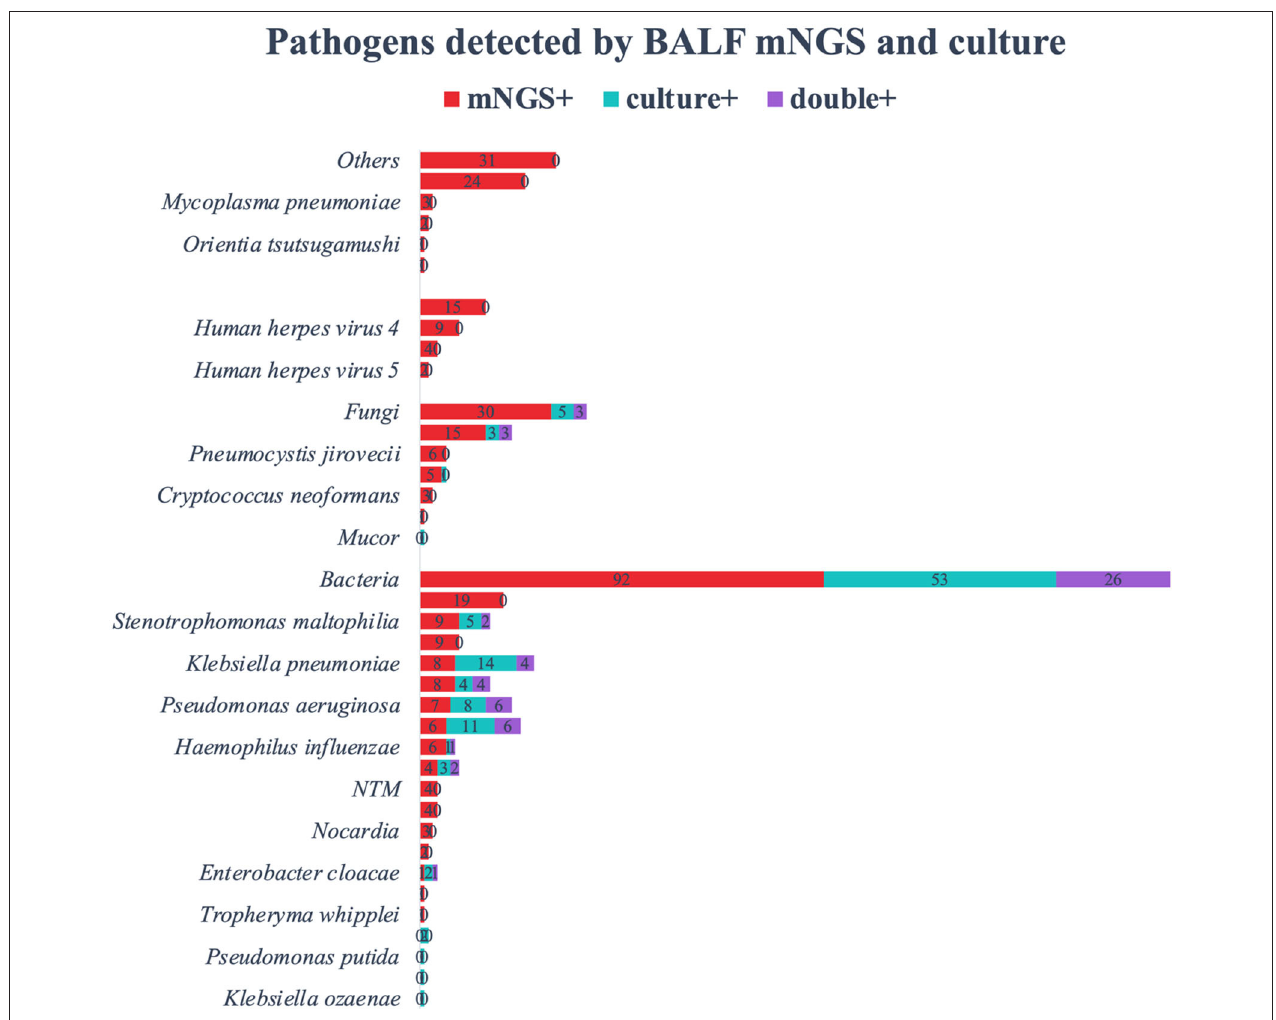
FIGURE 4 | The overlap of positivity between BALF mNGS and BALF culture. Bacteria were the most detected, followed by fungi, special pathogens, and viruses. The positive rate of BALF culture in detecting Klebsiella pneumoniae and Acinetobacter baumannii was higher than that of mNGS. Chlamydia psittaci was the most detected by mNGS, followed by Haemophilus parainfluenzae and Candida albicans. All viruses, special pathogens, MTB and NTM were only detected by mNGS, and the BALF culture of these pathogens were negative. BALF, bronchoalveolar lavage fluid; mNGS, metagenomic next generation sequencing; MTB, Mycobacterium tuberculosis ; NTM, nontuberculous mycobacteria